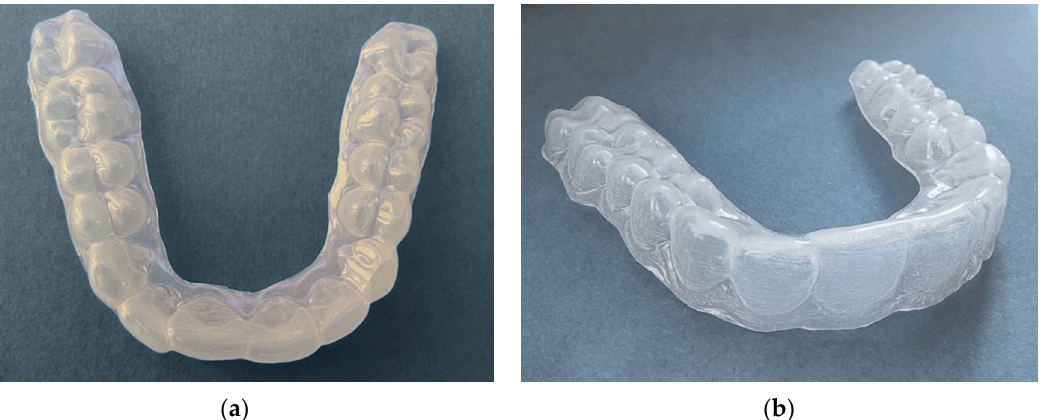
Figure 4. ( a , b ) show a tray manufactured from different points of view. The small portion of the gingival margin, aimed at protecting the gum and also at preventing the leaking of the whitening gel is clearly